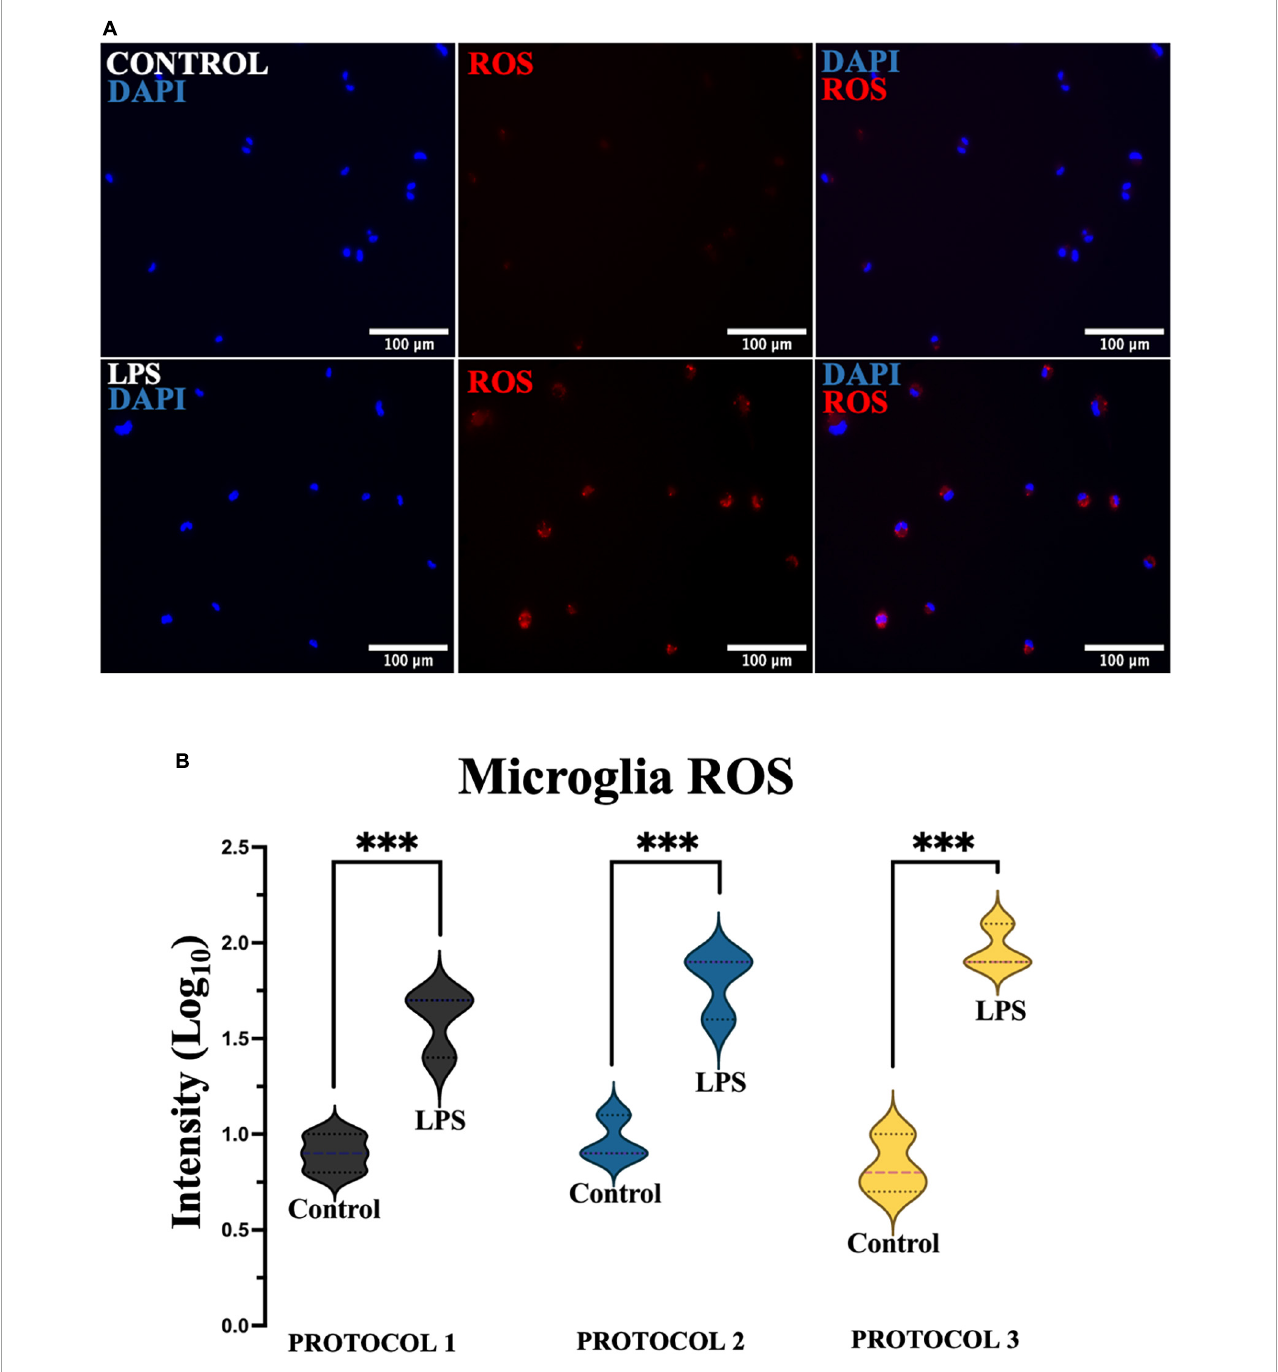
FIGURE10 Evaluation of oxidative stress. (A) Representative images of microglia (PROTOCOL 1) exhibiting ROS (red) and nuclei stained with DAPI (blue). Scale bar: 100 µ m. (B) Fluorescence intensity was measured, normalized, and normalized to log 10 . Data are presented as a violin plot. ∗∗∗ p <